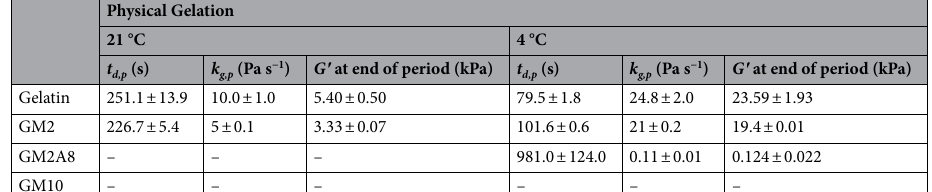
Table 2. Parameters describing the physical gelation of gelatin derivative solutions using the sequential cross- linking protocol: physical gelation delay time t d,p , initial increase rate k g,p of storage modulus G ′ upon cooling, and G ′ after cooling to 21 °C for 20 min and 4 °C for 40 min,